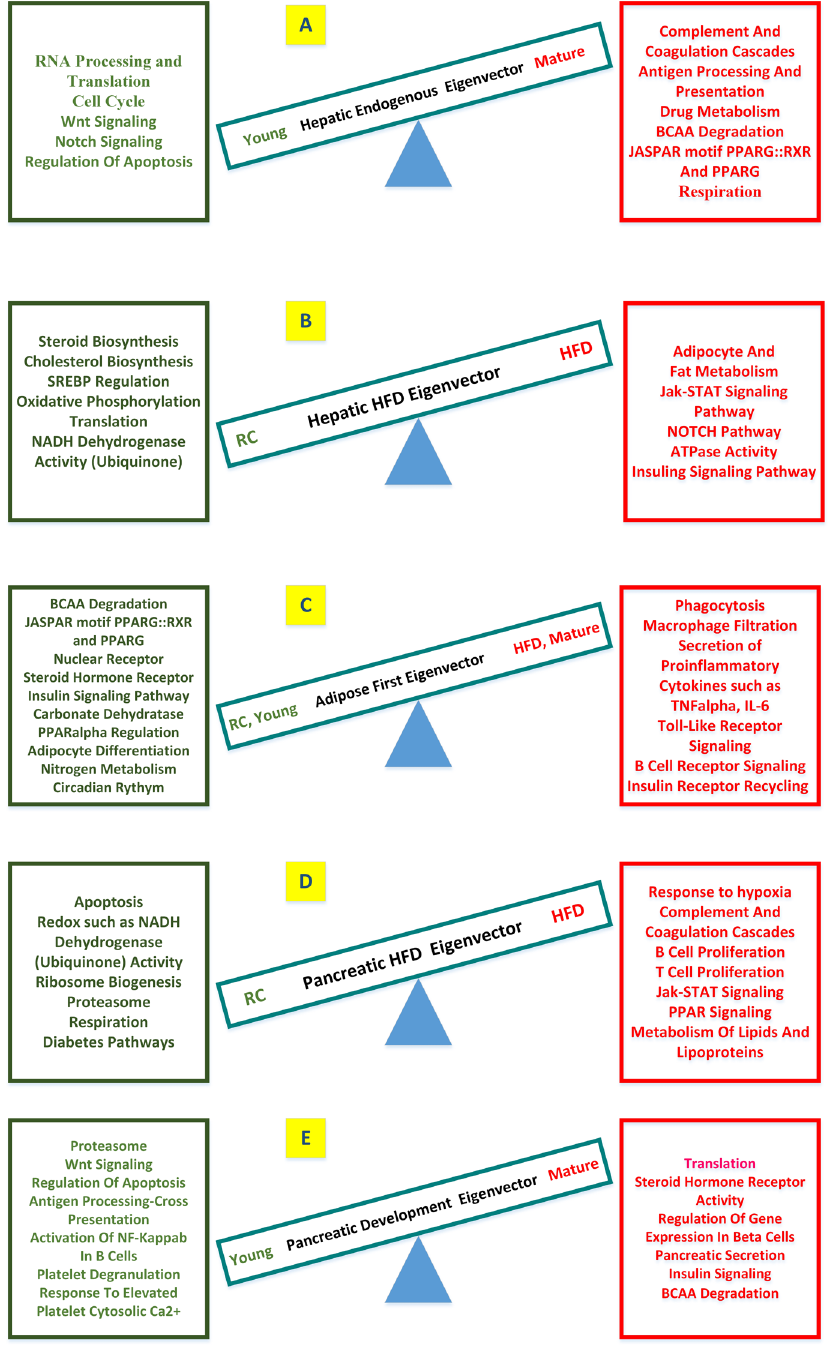
Figure 4. Summarization of the biological processes and molecular functions enriched at the two ends of the top gene eigenvectors. The up-enriched categories are shown on the right in red, whereas the down-enriched ones are shown on the left in green. ( A ) The hepatic first or endogenous gene eigenvector u coupled with v 1 in 1 Fig. 2C. ( B ) The hepatic HFD, or second gene eigenvector u coupled with v 2 in Fig. 2F. ( C ) The adipose first gene 2 eigenvector u coupled with v 1 in Fig. 3A. ( D ) The pancreatic HFD, or first gene eigenvector u coupled with v 1 in 1 1 Fig. 3B. ( E ) The pancreatic development, or second gene eigenvector u couplded with v 2 in Fig. 3C. Notably, the 2 KEGG pathway of valine, leucine and isoleucine degradation were down-enriched at the HFD and mature end of the top adipose eigenvector ( C ) while up-enriched at both the mature end of the hepatic first/endogenous eigenvector ( A ) and the mature end of the pancreatic second/development eigenvector ( E ). The JASPAR motif PPARG::RXR was down-enriched (p-value = 0.0082) at the HFD and mature end of the top adipose eigenvector ( C ) while up-enriched (p-value = 0.013) at the mature end of the hepatic first/endogenous eigenvector ( A